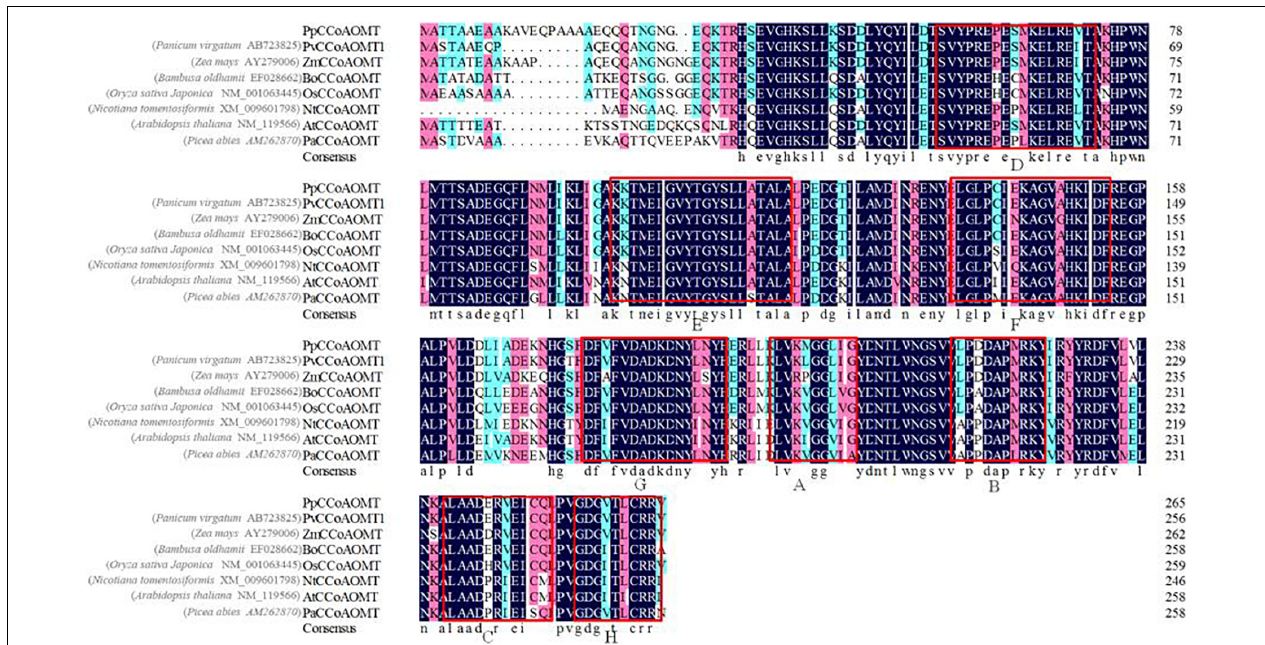
FIGURE 1 | Multiple sequence alignment indicated that the CCoAOMT amino acid sequence of elephant grass ( Pennisetum purpureum ) contained motifs that were highly conserved in other species. Red hollow boxes indicate conserved motif